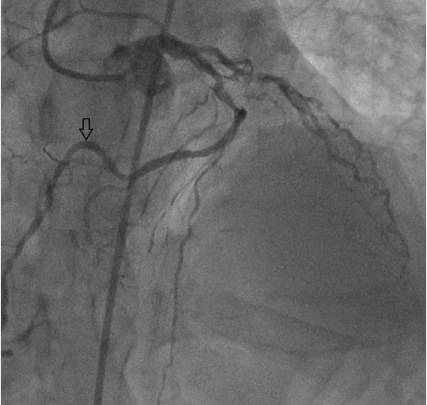
Figure 7: Coronary angiographic appearance of the right coronary